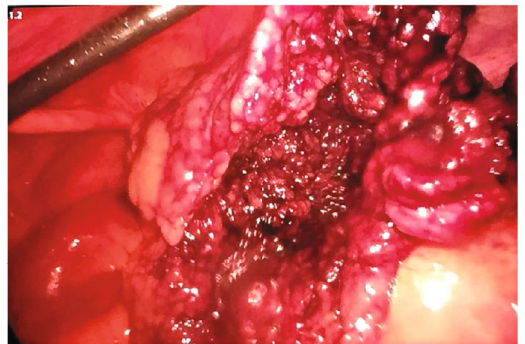
Figure 1: Omental mass - laparoscopic view.